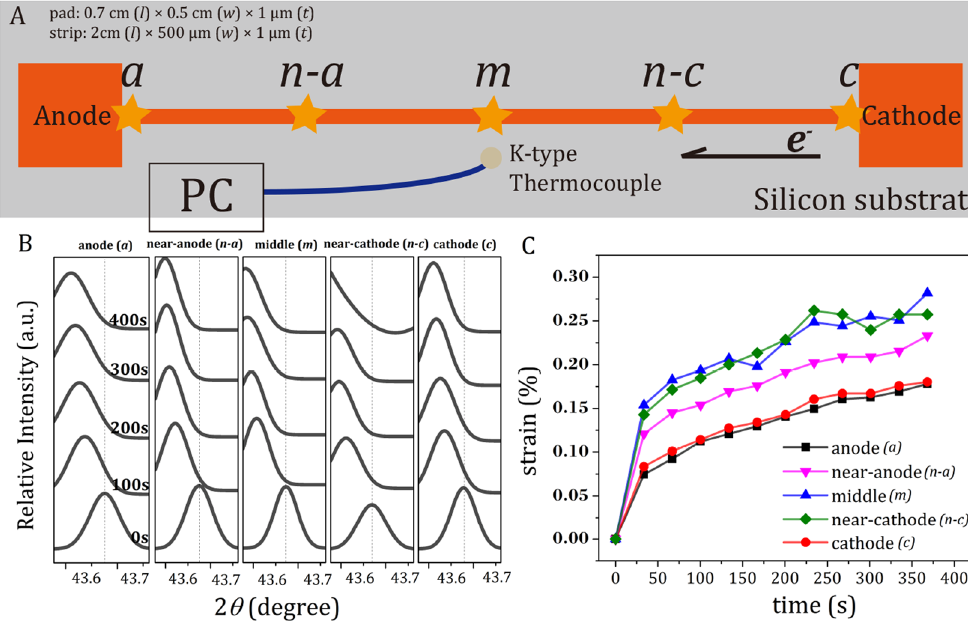
Figure 1. ( A ) The schematic diagram of the dog-bone-shape pure Cu samples. Five positions along the Cu strip, namely the “anode” ( a ), “near anode” ( n-a ), “middle” ( m ), “near cathode” ( n-c ), and “cathode” ( c ),